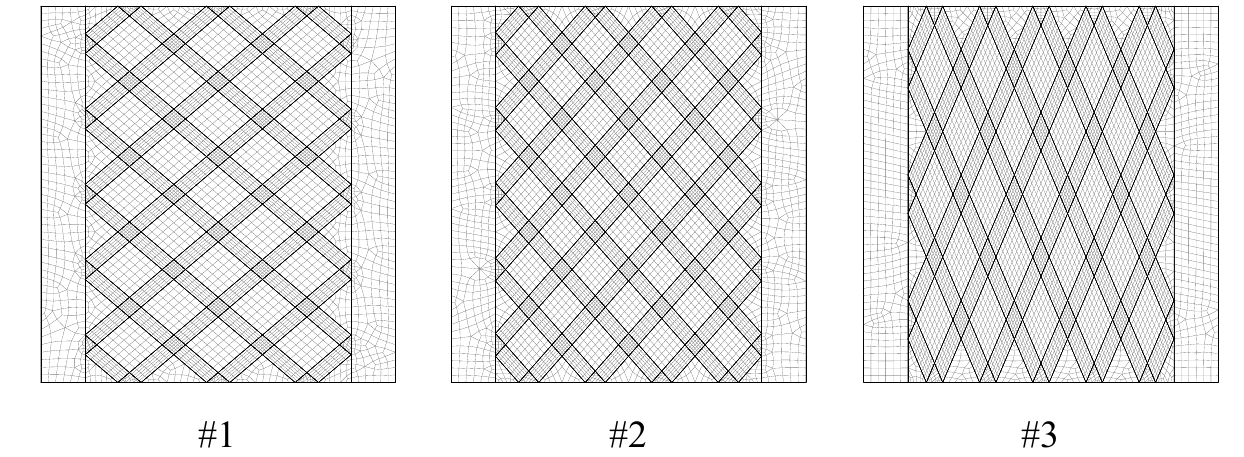
Figure 6. 2D grid topology of the unwrapped model #1, #2 and